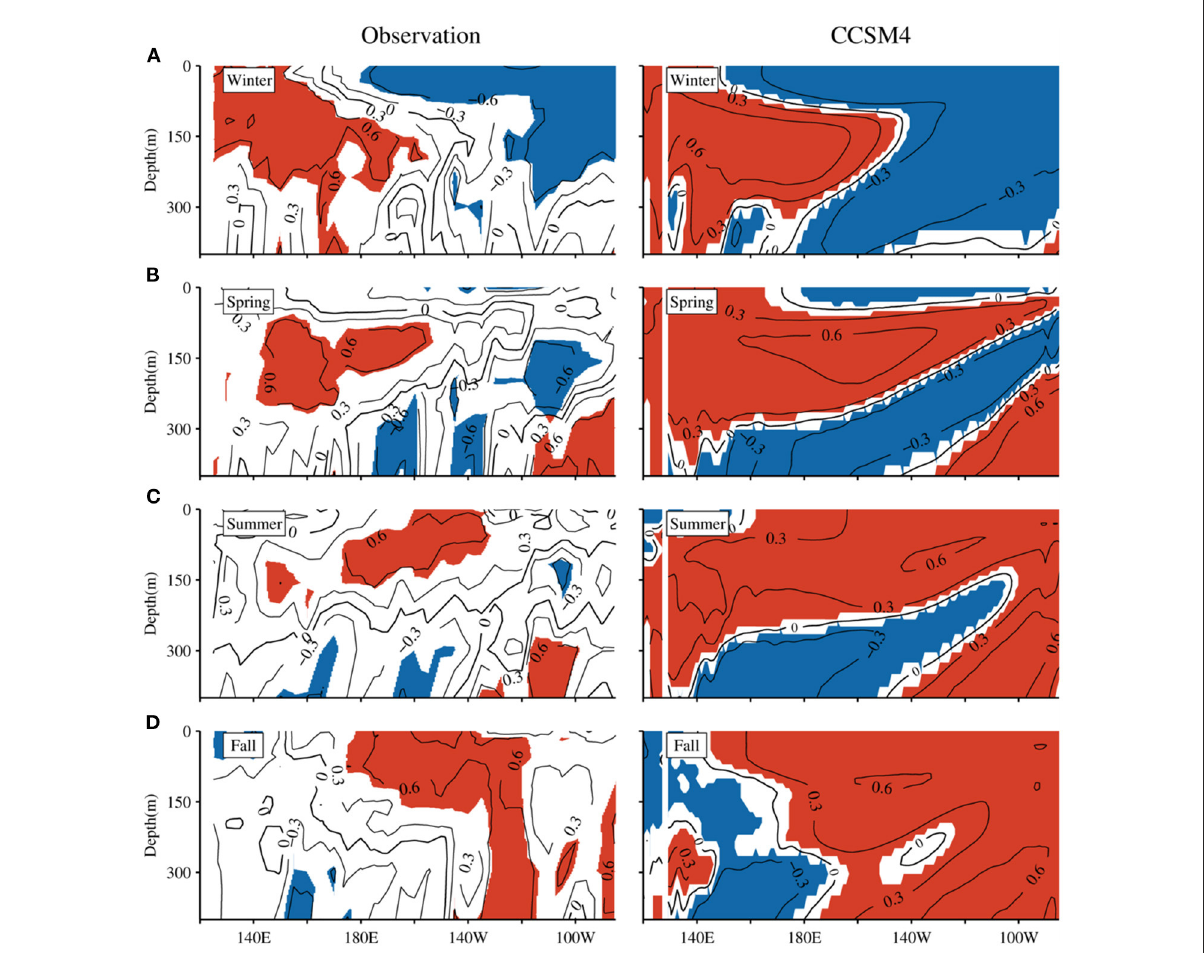
FIGURE6 Comparison of observed (left column) and simulated (right column) lag correlations between the SSTA in STIO in fall and the temperature anomalies in the Pacific equatorial vertical section in the following four seasons during the positive phases of the decadal variability (from 1990 to 2003 in the observation). (A) Winter (December to February). (B) Spring (March to May). (C) Summer (June to August). (D) Autumn (September to November). The contour interval is 0.3. Red and blue shades indicate 90% confidence level of positive and negative correlation, respectively. The model correlations are nearly everywhere above the 95% significance level due to the long time series.